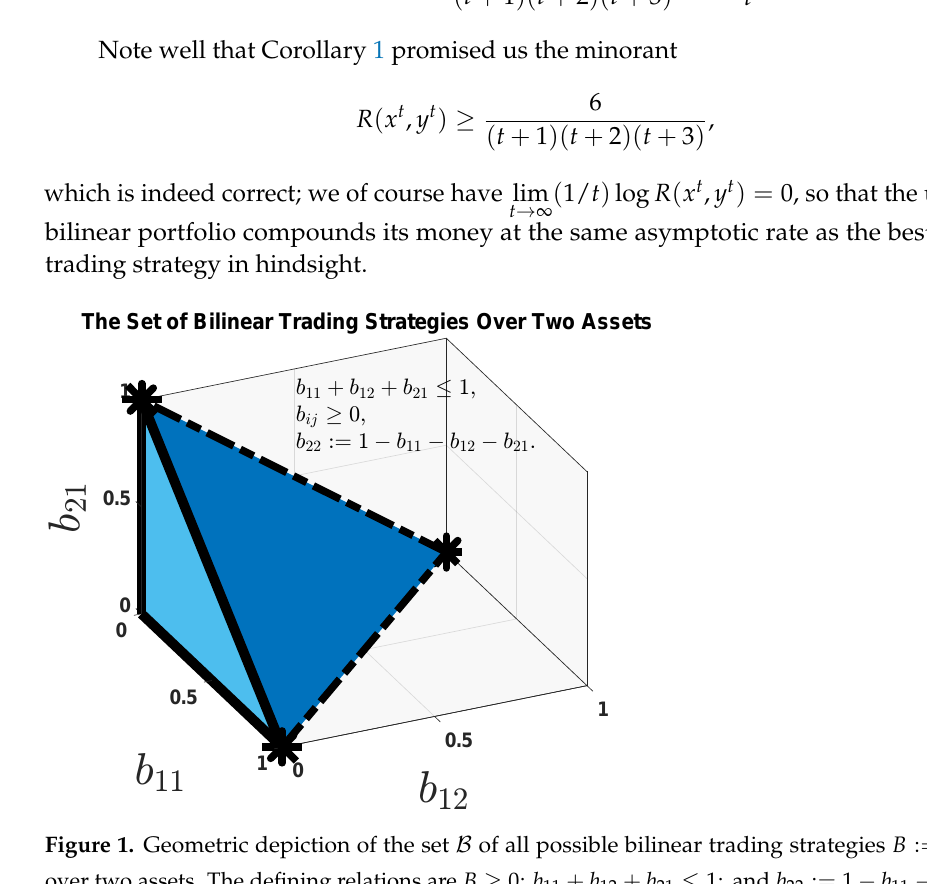
Figure 1. Geometric depiction of the set B of all possible bilinear trading strategies B : = over two assets. The defining relations are B ≥ 0; b 11 + b 12 + b 21 ≤ 1; and b 22 : = 1 − b 11 − b 12 − b 21 . The volume of this tetrahedron is